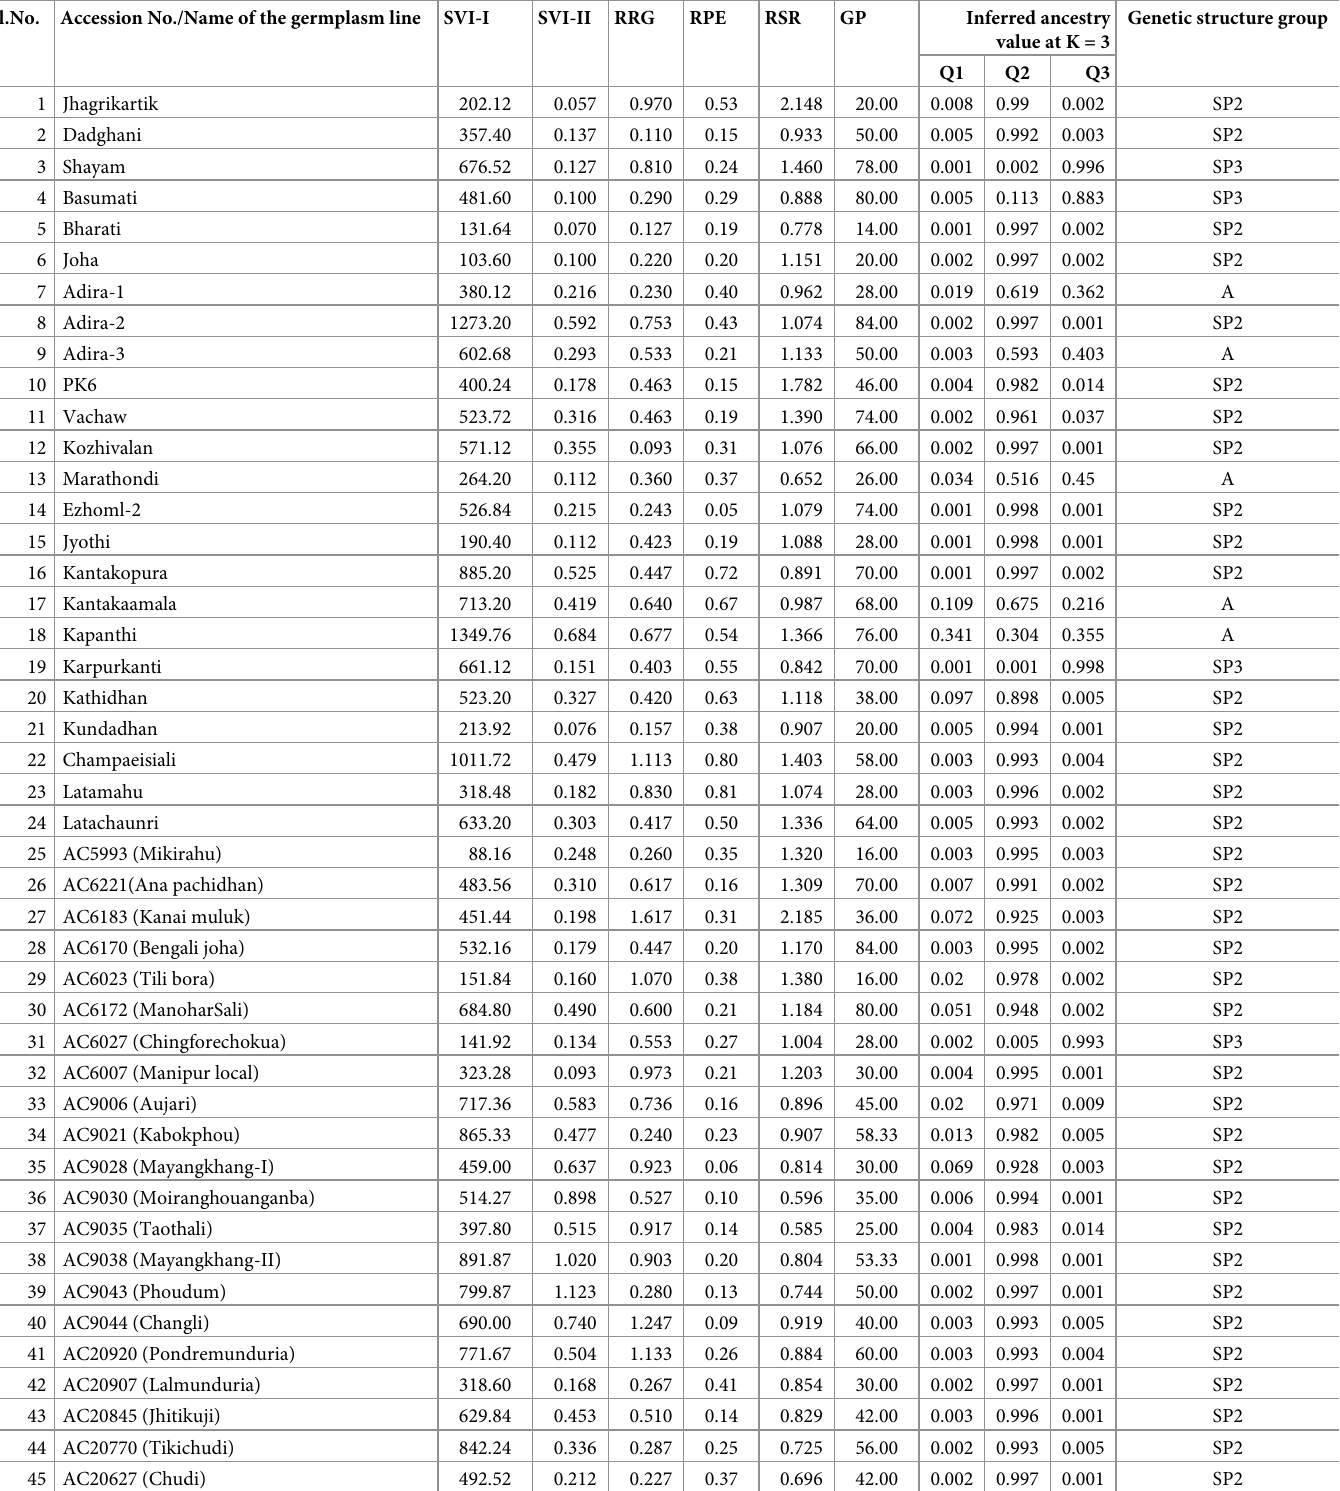
Table 1. Mean estimates of SVI-1, SVI-II, RRG, RPE, RSR, GP and genetic structure ancestry value at K = 3 for the panel population containing 120 landraces. Sl.No. Accession No./Name of the germplasm line